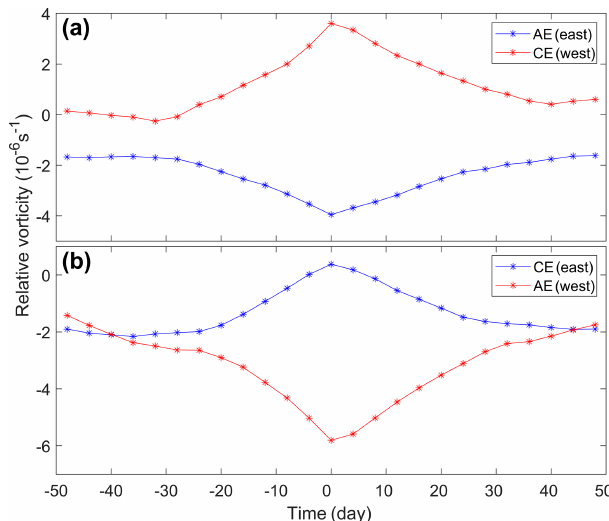
Figure 7. Distribution of relative vorticity in area bordered by red boxes in Fig. 2. (a) Relative vorticity of AE mode over time. Blue (red) line represents time series of relative vorticity of AE (CE) on east (west) side of LS, which corresponds to Fig. 6. (b) Relative vorticity of CE mode over time. Blue (red) line represents time se- ries of relative vorticity of CE (AE) on east (west) side of LS, which corresponds to Fig. 8. Figure based on HYCOM